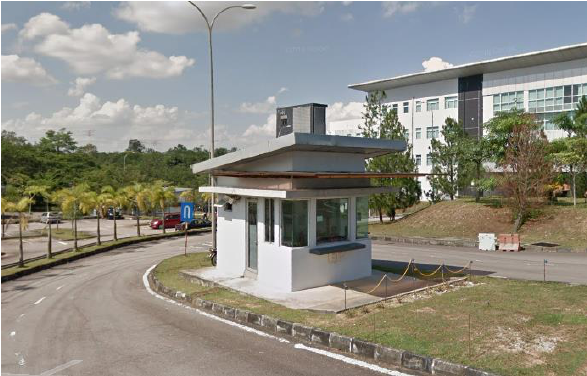
Figure 4. Model of a guard